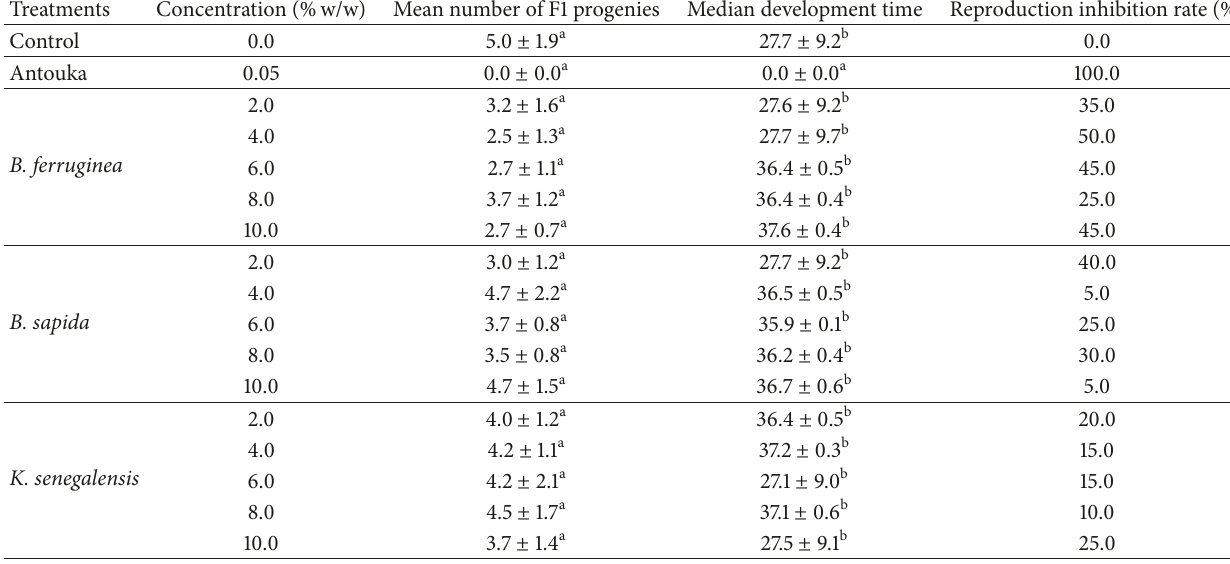
Table 3: Effect of treating yam chips with crude powders of B. ferruginea , B. sapida , and K. senegalensis on F1 progeny emergence and median development time (mean ± SE) of D. porcellus .